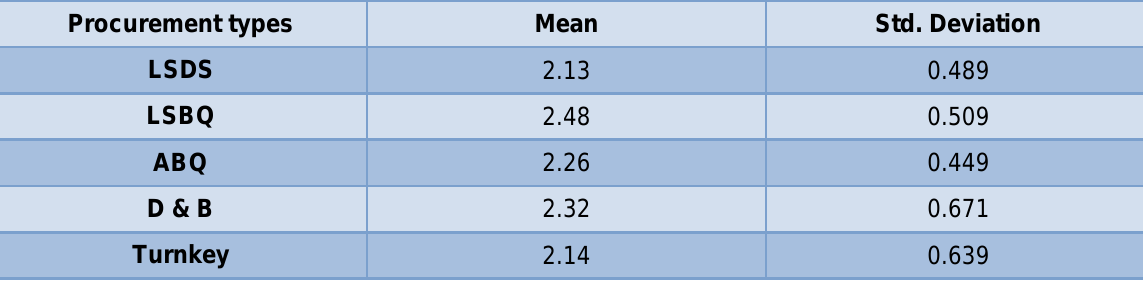
Table 4 Mean value of the respondent’s level of satisfaction Mean ranging from 1.00 to 1.50 = low; mean ranging from 1.50 to 2.50 = medium; and mean ranging from 2.50 to 3.00 =